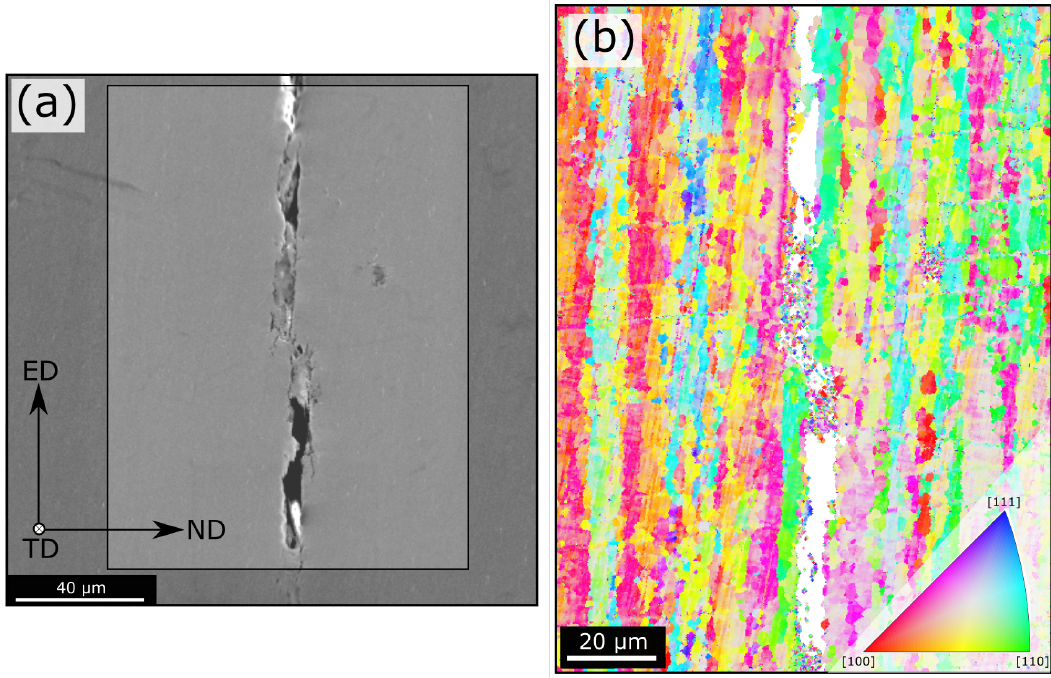
Figure 13. ( a ) SE-SEM image of a DCB crack in sample H-WQ-T6. ( b ) Corresponding EBSD map from the highlighted area in ( a ). Cracking predominantly follows the high-angle grain boundaries separating the long fibrous grains aligned along the extrusion direction